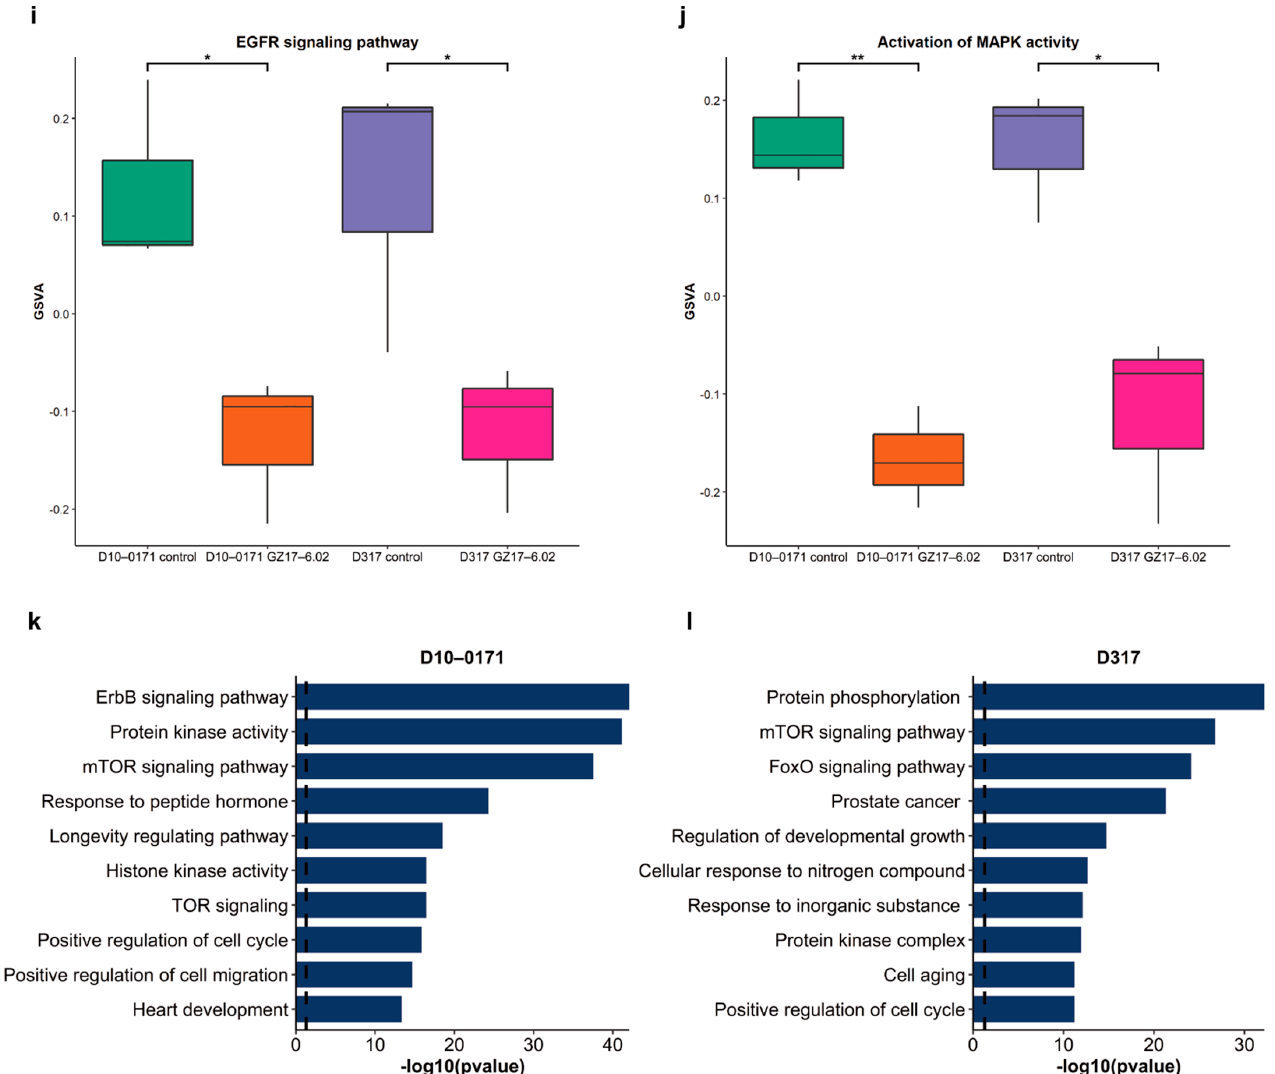
Figure 4. GZ17-6.02 induces changes in gene and protein expression in GSCs. ( a ) PCA plot of transcriptome data demonstrates separation of control and GZ17-6.02 treated D10-0171 and D317 GSCs. ( b ) Venn diagram of shared and unique differentially expressed genes in GZ17-6.02 treated D10-0171 and D317 GSCs. ( c ) Volcano plot of differentially expressed genes in D10-0171 following GZ17-6.02 treatment. ( d ) Volcano plot of differentially expressed genes in D317 following GZ17-6.02 treatment. Shared differentially expressed genes in GZ17-6.02 treated D10-0171 and D317 GSCs that are associated with glioblastoma growth and invasion are labeled on both volcano plots. ( e ) Top 10 downregulated pathways in D10-0171 following GZ17-6.02 treatment identified by GSEA using the Hallmark database as reference. ( f ) Enrichment plots for E2F targets and G2M checkpoint in GZ17-6.02 treated D10-0171 GSCs. ( g ) Top 10 downregulated pathways in D317 following GZ17-6.02 treatment identified by GSEA using the Hallmark database as reference. ( h ) Enrichment plots for glycolysis and oxidative phosphorylation in GZ17-6.02 treated D317 GSCs. ( i ) GSVA comparison of EGFR signaling pathway in control and GZ17-6.02 treated D10-0171 and D317 GSCs. ( j ) GSVA comparison of activation of MAPK activity pathway in control and GZ17-6.02 treated D10-0171 and D317 GSCs. ( k ) Functional enrichment analysis (Metascape [36]) of downregulated pathways across input gene lists of phospho-proteins in D10-171 showing decreased expression following GZ17-6.02 treatment. ( l ) Functional enrichment analysis (Metascape [36]) of downregulated pathways across input gene lists of phospho-proteins in D317 showing decreased expression following GZ17-6.02 treatment. Dashed lines represent a p -value of 0.05 * p < 0.05, ** p < 0.01, *** p < 0.001. DEG, differentially expressed gene; NES, normalized enrichment score; mTOR, mammalian target of rapamycin; EGFR, epidermal growth factor receptor; GSVA, gene set variation analysis; TOR, target of rapamycin.